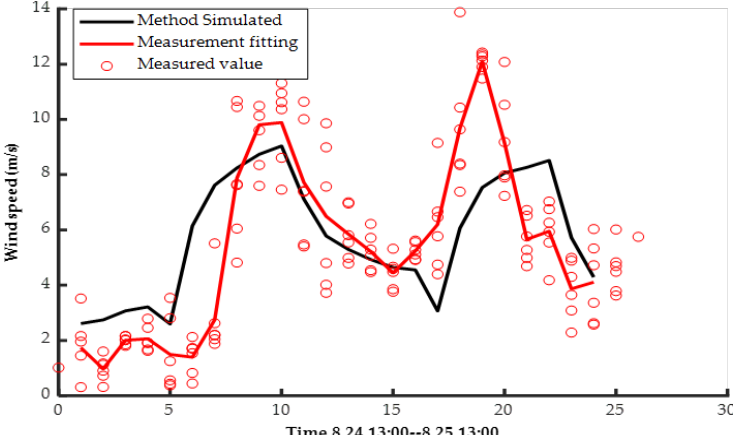
Figure 3. Comparison of measured and simulated wind speed at observation stations during Typhoon Bailu.